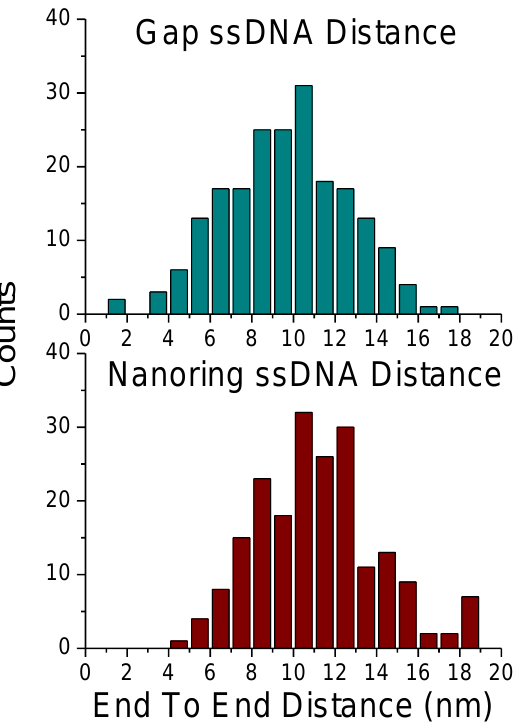
Figure 4. Histograms of end-to-end distance of gap ssDNA and nanoring ssDNA. Statistical comparison of end-to-end distances show a significant increase in nanoring construct compared with the gap construct ( p < 0.001).